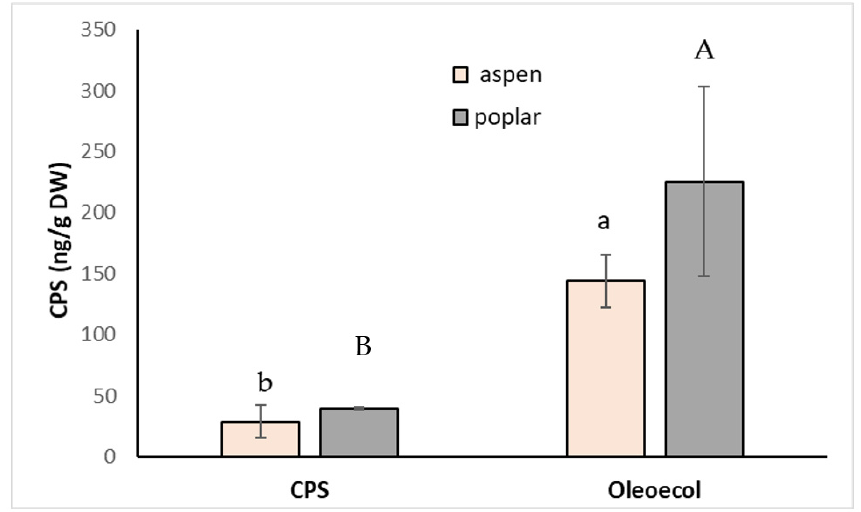
Figure 5. Concentration of CPS in the roots of poplar and hybrid aspen sprayed with 0.250 mL solution of CPS (3 mg L − 1 ) or the insecticide Oleoecol (0.250 mL) at the producer´s recommended concentration. Samples were collected 10 days after foliage application. Different letters mean statistically significant differences ( p ≤ 0.05). Table 3. Activity of antioxidant enzymes (APX—ascorbate peroxidase; SOD—superoxide dis- mutase; CAT—catalase; POX—peroxidase; GST—glutathione-S-transferase) in leaves of the poplar